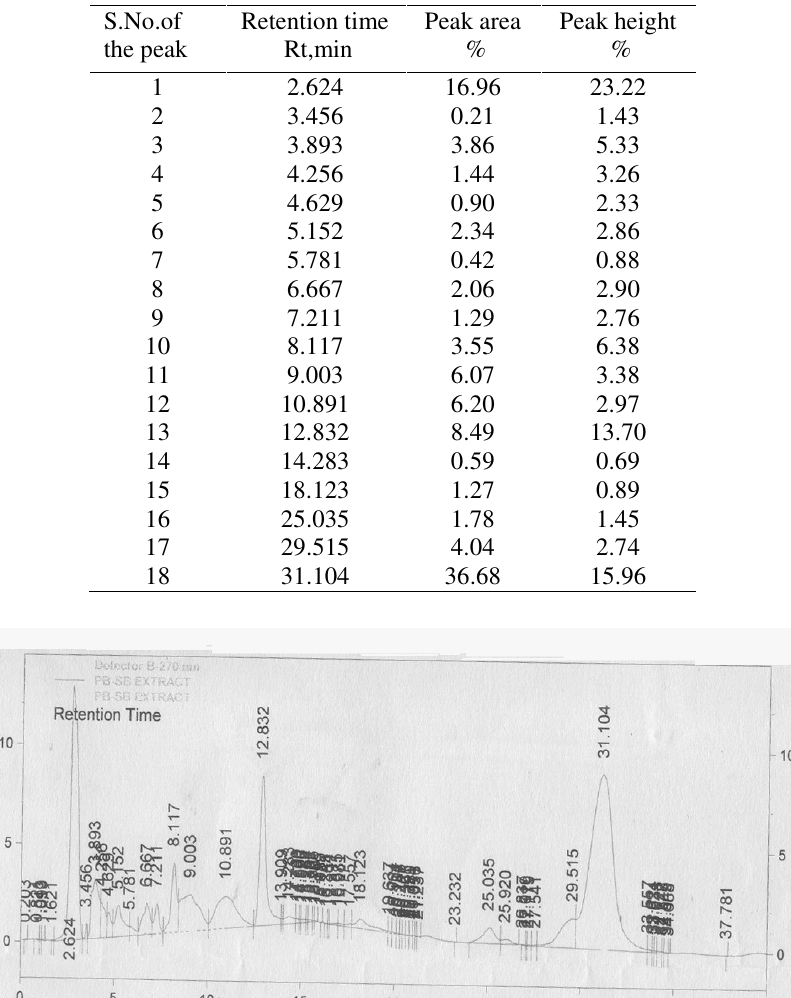
Table 9 . HPLC alkaloid profile of S.potatorum seed